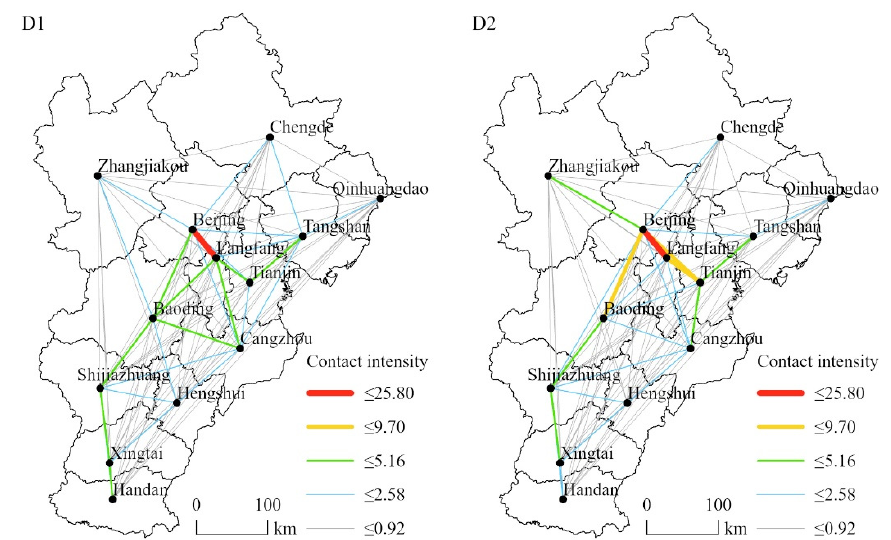
Figure 5. Comparison of population mobility network patterns in D1 and D2.